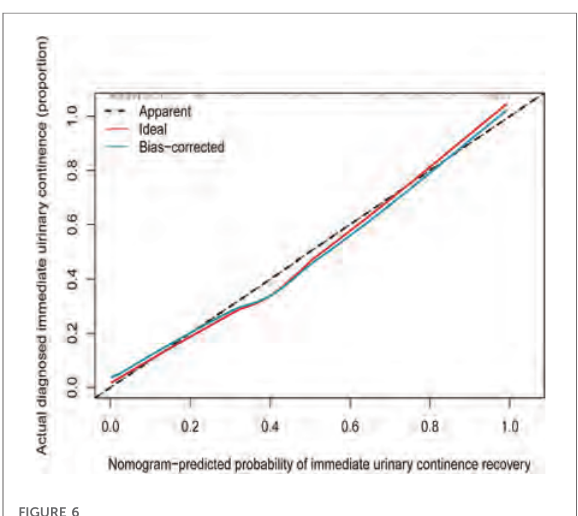
FIGURE 6 Calibration curves of the immediate urinary continence recovery nomogram prediction in the cohort. Notes: The x -axis represents the predicted possibility of immediate urinary continence recovery. The y -axis represents the actual diagnosed immediate urinary continence. The diagonal dotted line represents a perfect prediction by an ideal model. The solid line represents the performance of the nomogram, of which a closer fi t to the diagonal dotted line represents a better